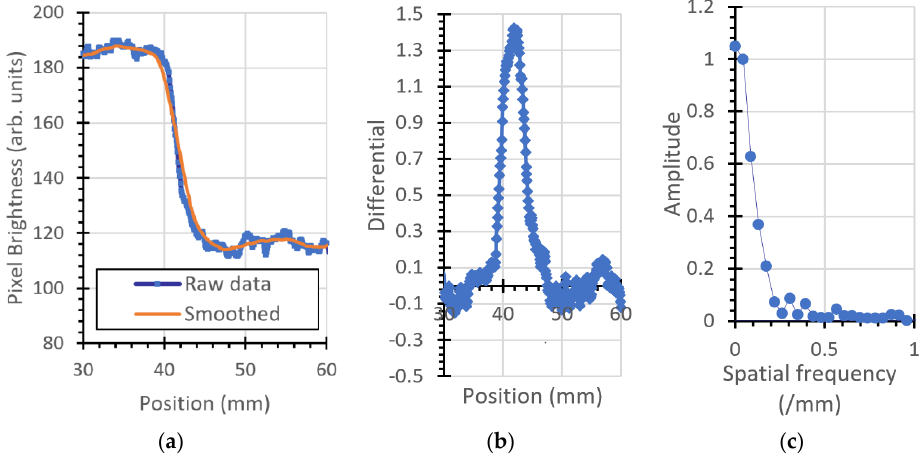
Figure 11. Steel block: ( a ) ESF, ( b ) LSF (inverted for clarity), and ( c ) MTF. A summary of the results is given in Table 2. Table 2. MTF measurements from different locations from within the image.